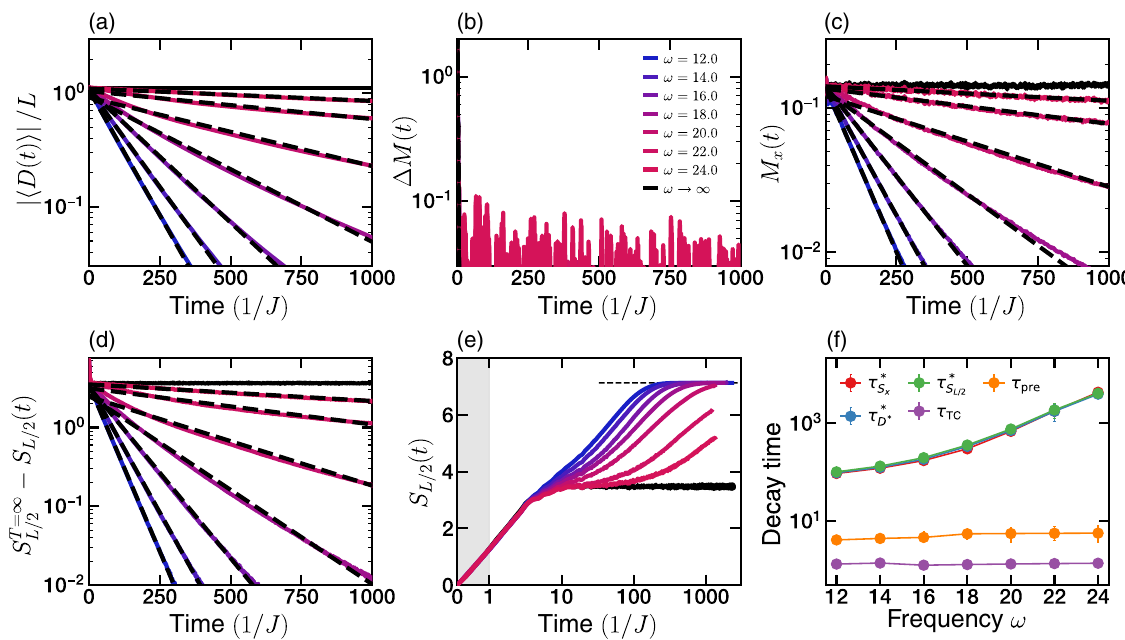
FIG. 8. Analogous to Fig. 7, but considering an initial state time evolved with the short-range Floquet evolution. As in Fig. 7, we observe that a simple exponential decay captures the broad features of the approach of the different quantities to their thermal values. Moreover, we also observe a good agreement between the τ (cid:2) D , τ (cid:2) S , and τ (cid:2) S as measures of the thermalization time τ (cid:2) . However, unlike (cid:2) L= 2 x the long-range case, the time crystalline order parameter (b) decays at a much faster, frequency-independent, timescale. This time is on the same order of τ , further corroborating that, in this case, the decay of the time crystalline order arises from the dynamics of the pre prethermal